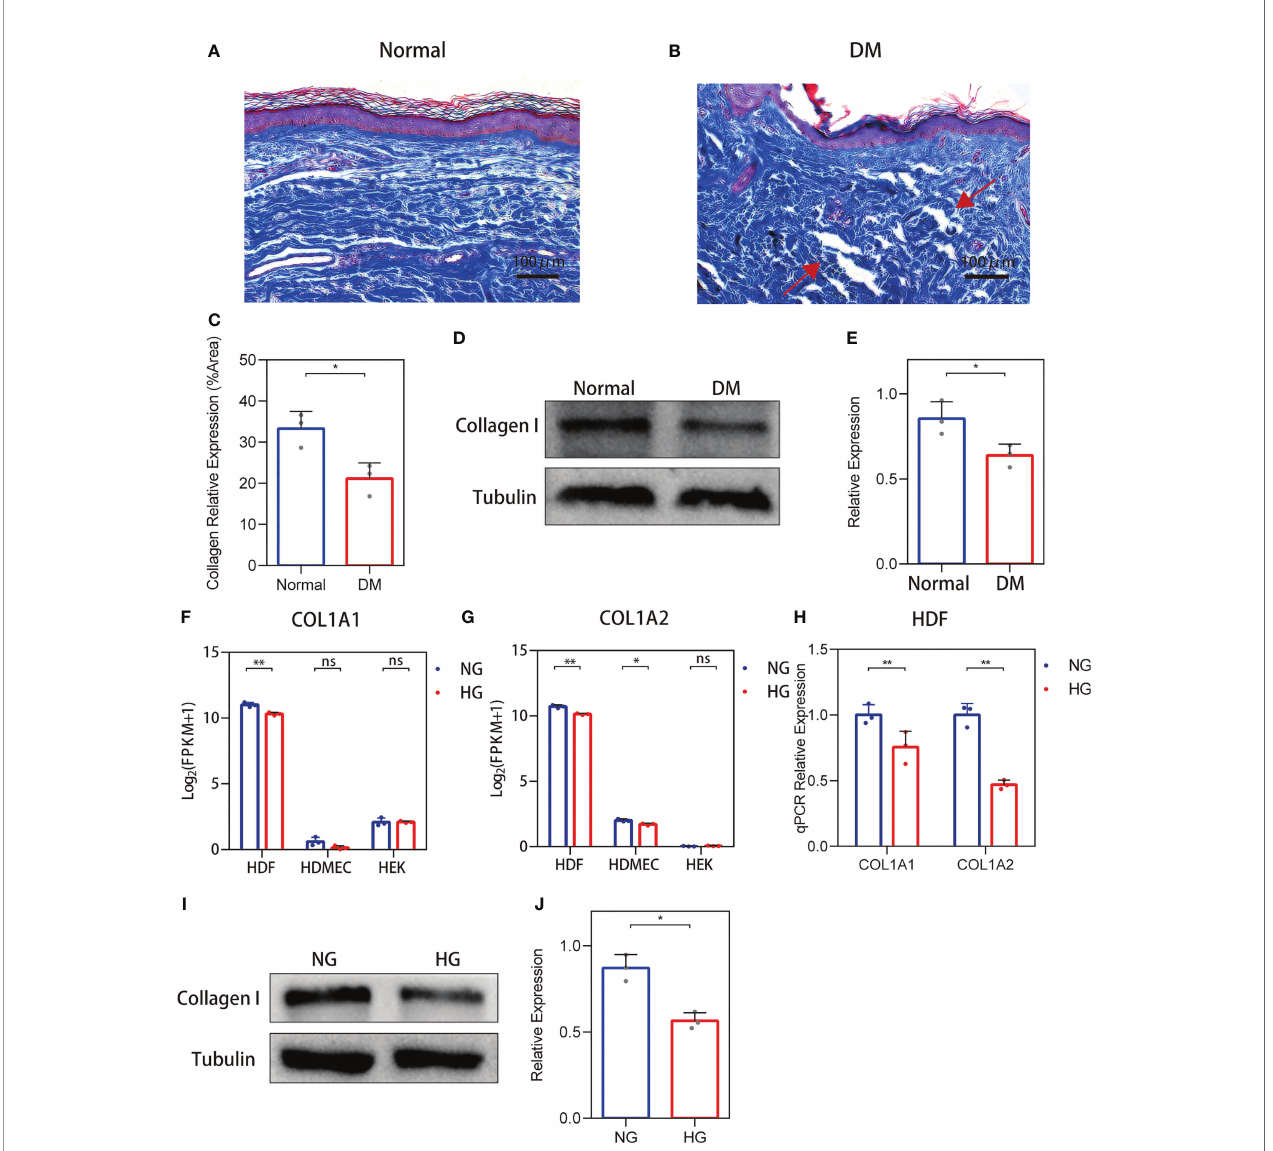
FIGURE 1 | Changes in the collagen deposition and expression of diabetic skin. (A, B) Representative Masson ’ s trichrome stain of non-diabetic ( n = 6) and diabetic skin ( n = 7). (C) The quantitative analysis of collagen stain. (D, E) Western blot and their quantitative analysis of collagen I expression in skin. (F, G) COL1A1 and COL1A2 mRNA expressions in three primary human skin cell types — human dermal fi broblasts (HDFs), human dermal microvascular endothelial cells, and human epidermal keratinocytes — cultured with high glucose. (H) RT-qPCR veri fi cation of the RNA-seq data. (I, J) Western blot and their quantitative analysis of collagen I expression in HDFs cultured with high glucose. The results are provided as the means ± SEM, *p < 0.05, **p < 0.01 and ‘ ns ’ means no signi fi cance compared with the